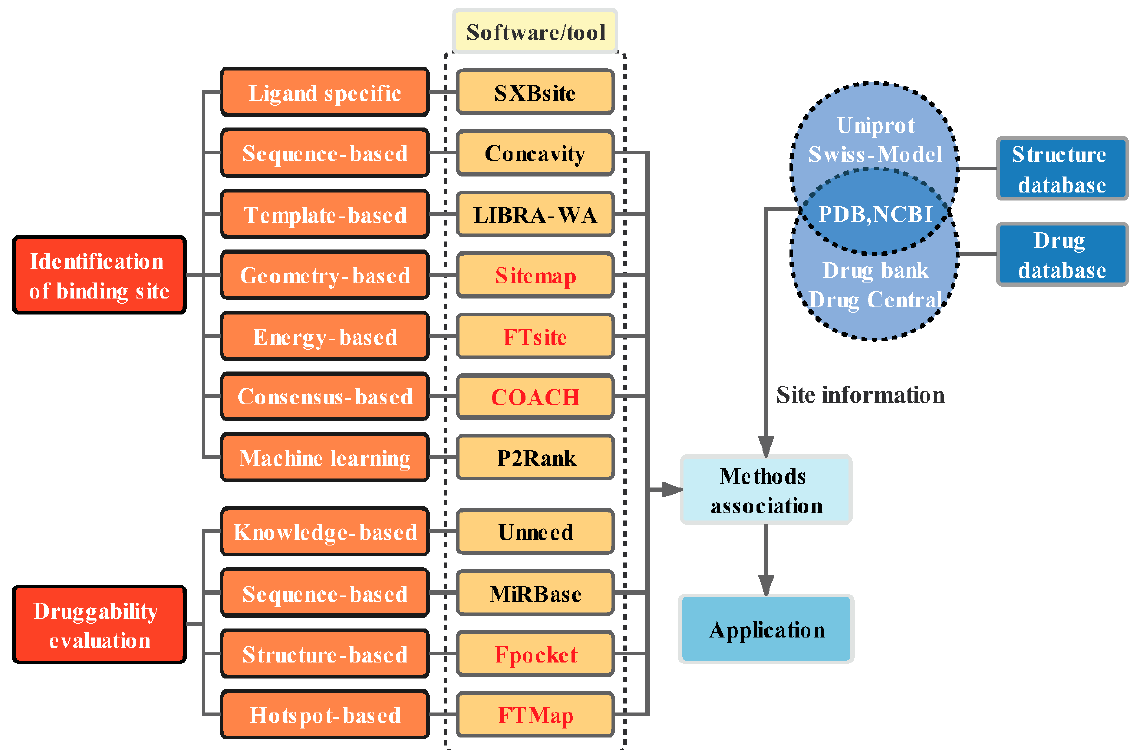
Figure 2. Overview of binding site identification and druggability evaluation.